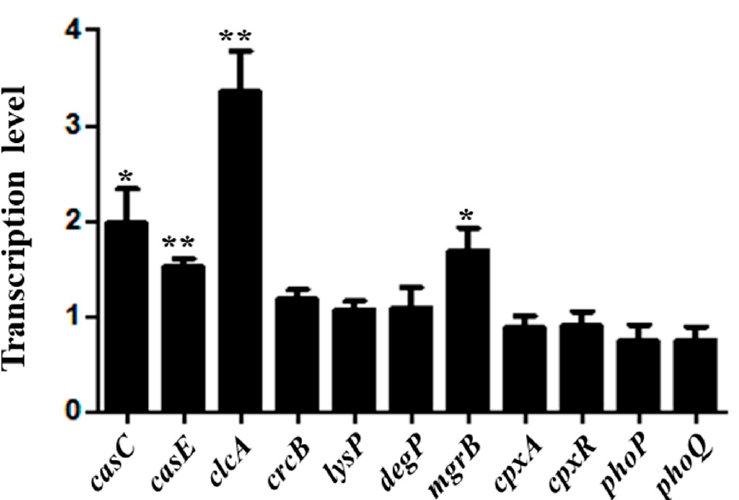
Figure 3. Validation of the genes identified by Tn-seq using qRT-PCR. The WT strain was cultivated at pH 7.0 and pH 4.0, the transcriptional levels of indicated genes show the difference relative to the WT cultured at pH 7.0. gyrB was used as the standard gene. Error bars were shown as Standard error of means (SEM)( n = 3). *, p ≤ 0.05; **, p ≤ 0.01 (Student’s t -test).